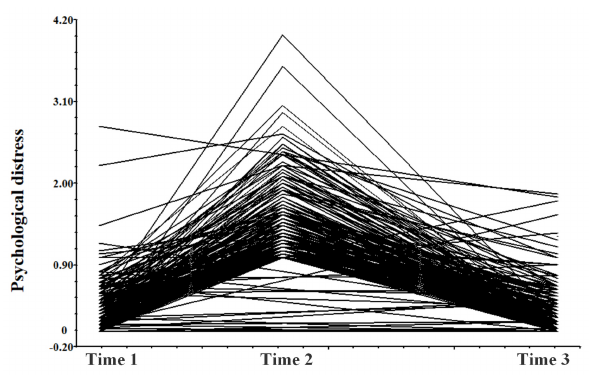
Fig. 1. Observed scores on DASS-21 for the three waves of data collection ( n =